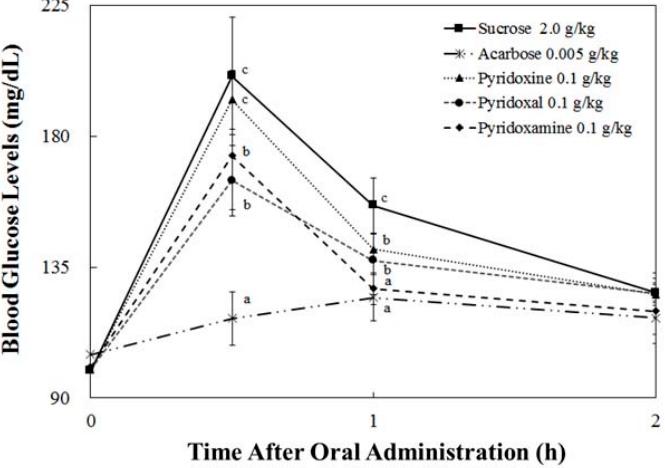
Figure 5. Postprandial blood glucose-lowering effects of pyridoxine, pyridoxal, and pyridoxamine in the sucrose loading test. After fasting for 24 h, six-week-old, male SD rats were orally administered with a sucrose solution (2.0 g/kg) with or without samples (pyridoxine, pyridoxal, pyridoxamine, and Acarbose). Each point represents mean ± S.D ( n = 5). The letters in lowercase ( a–c ) indicate significant differences ( p < 0.05) at 0.5 h and 1.0 h, respectively, via Duncan’s test.